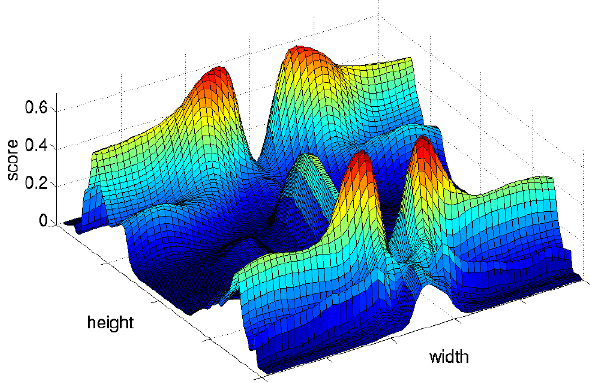
Figure 2. Visualization of the scores of the